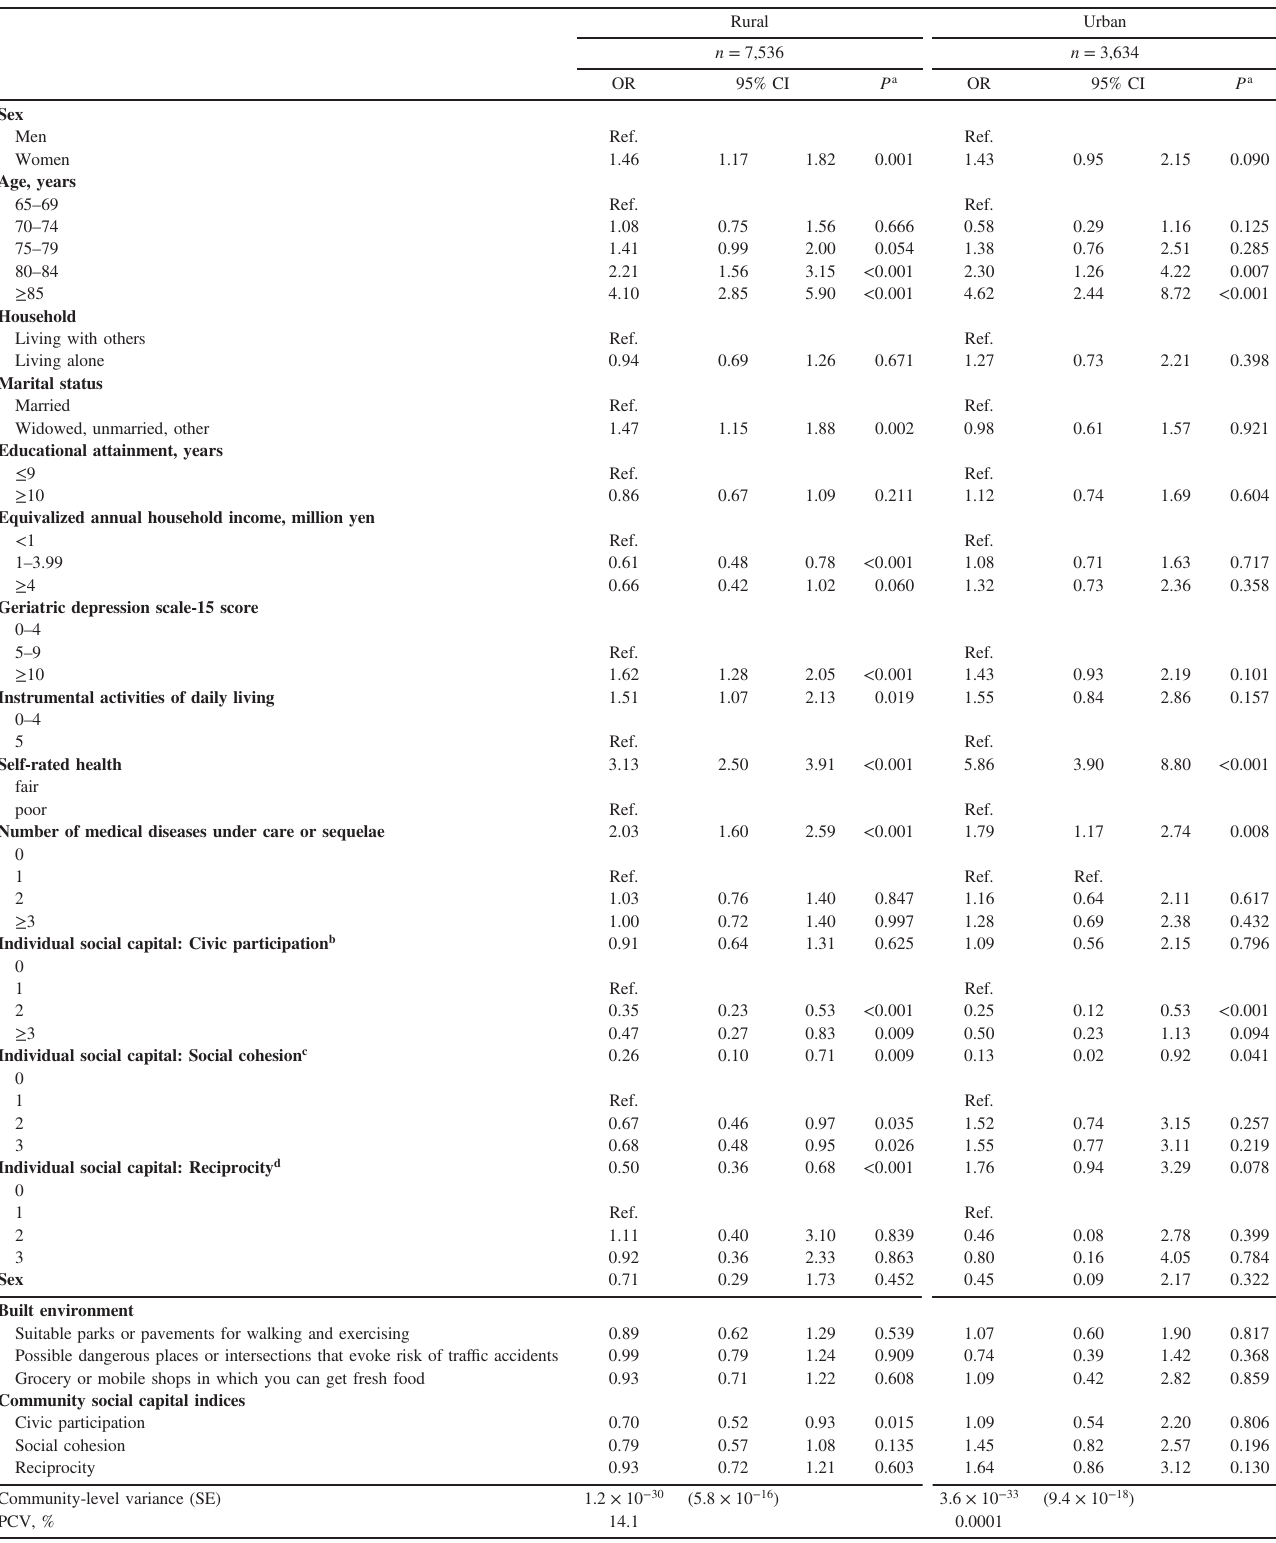
Table 5. Result of multilevel logistic regression models combining all community level factors (ie, SC and neighborhood built environment) by rural and urban